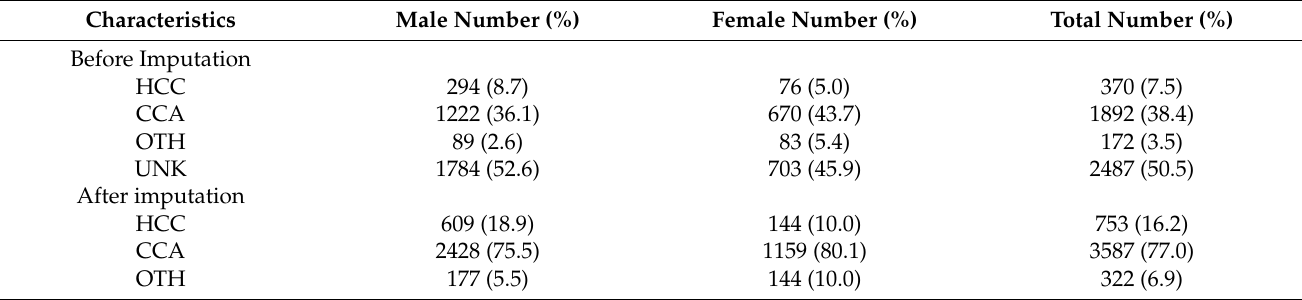
Table 1. Number and percentage of liver cancer cases by sex and histology before and after 1